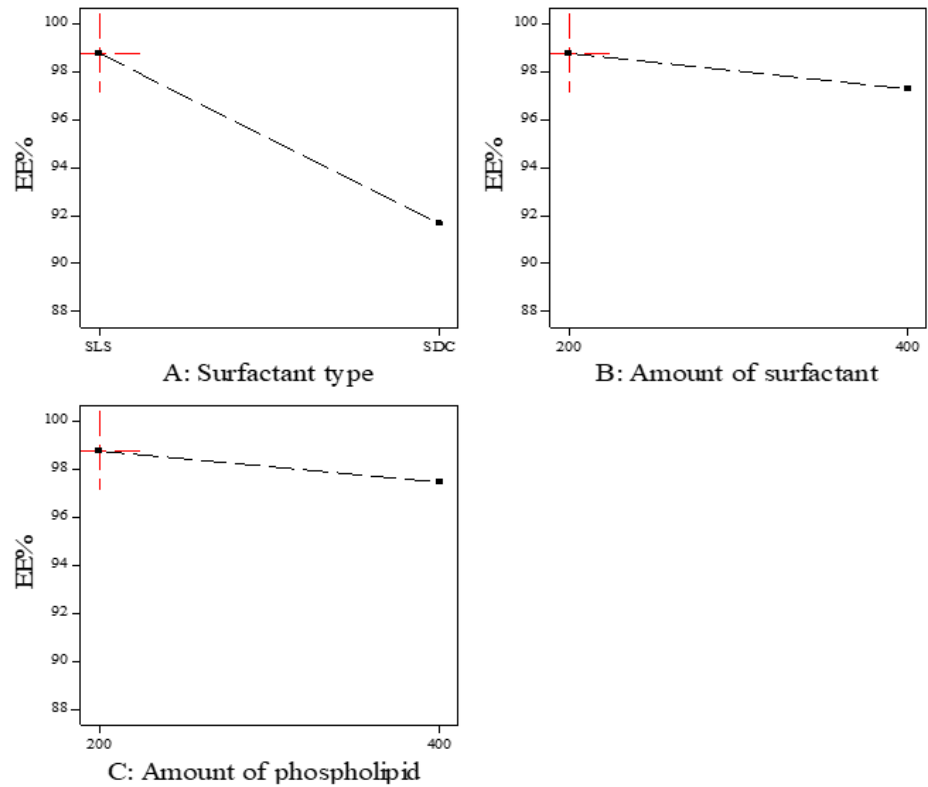
Figure 1. The effect of formulation factors in the EE% (Y1).